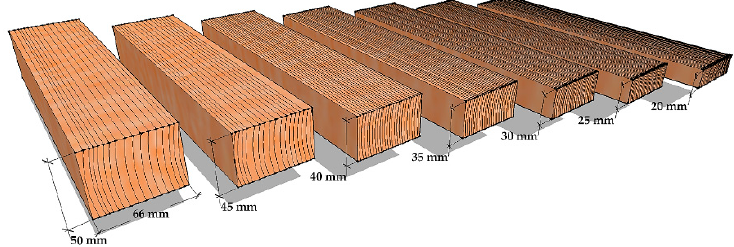
Figure 2. Scheme of gradual comparison of the thickness of the central radial sample.